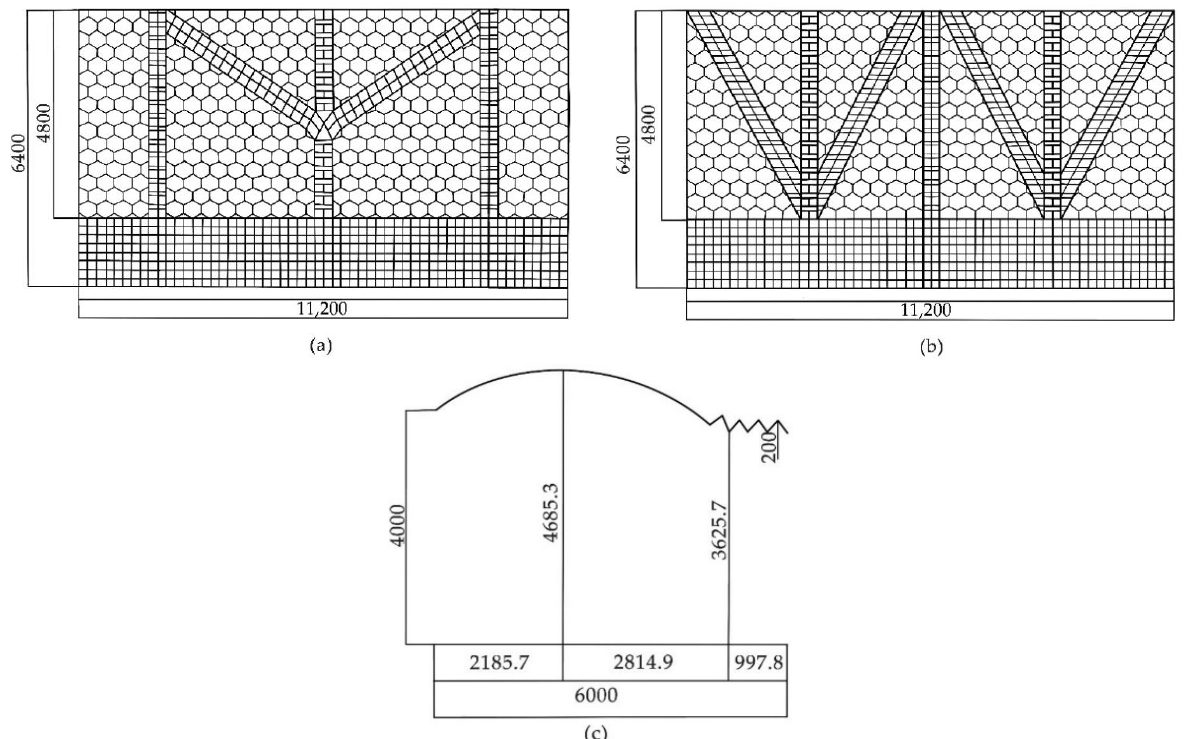
Figure 3. The design of two new energy vehicle charging post carports through the dragonfly wing grid study, with ( a ) a floor plan for model 1, ( b ) a floor plan for model 2 and ( c ) an elevation plan for model 1 and model 2.